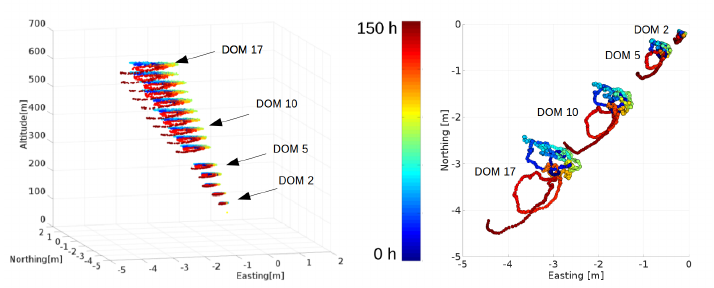
Figure 1. Left: Movements of all available DOMs installed in the operational detection unit at the KM3NeT underwater site of Capo Passero (o ff the Sicilian coasts) with respect to the nominal positions. Positions were computed during 150 hours of data acquisition with a time resolution of 10 minutes. The color scale refers to the time from the start of the measurement. Right: Top view of the movements of four reference DOMs. DOM positions have been filtered by using a 2 hours long moving average